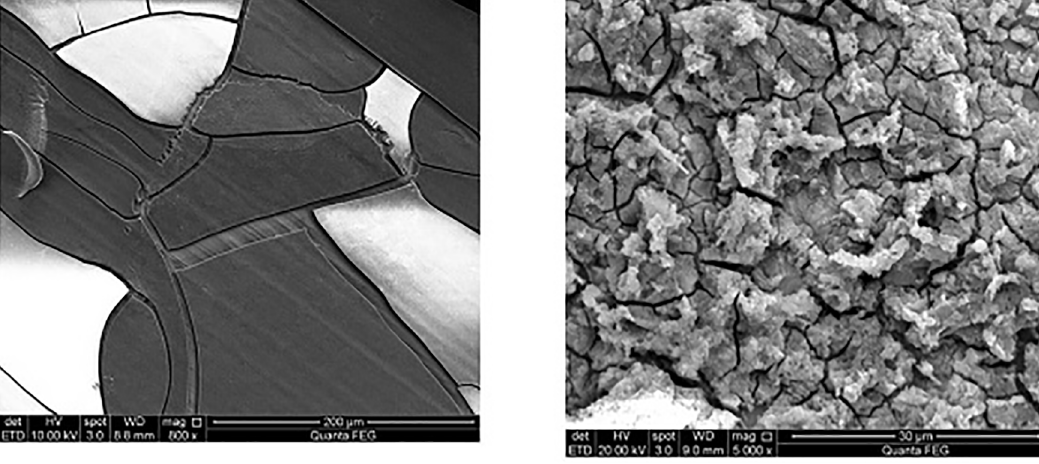
Figure 4. Surface morphology of the coated AISI 304 steel with gelatin after conducting the corrosion